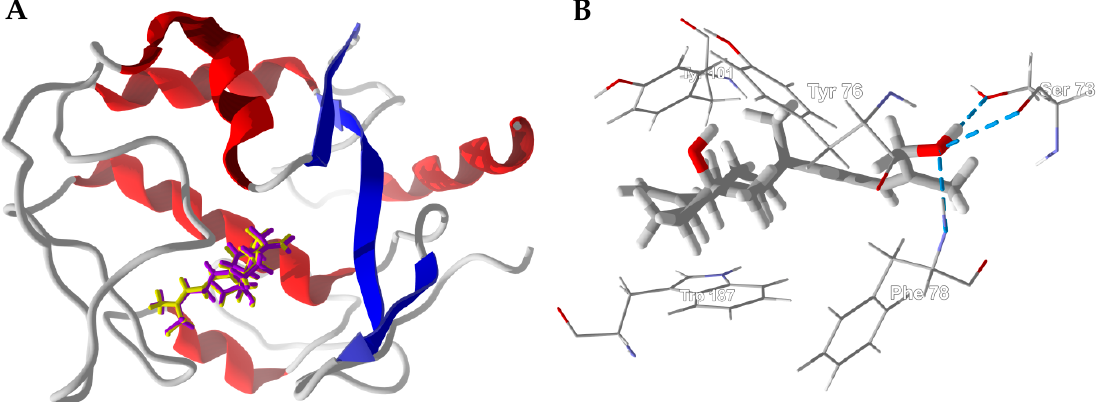
Figure 9. Human folate receptor β (HsFR β , PDB 4kn1). ( A ): Ribbon structure of protein showed the docked poses of boscartin A (yellow) and boscartin B (purple). ( B ): Lowest-energy docked pose of boscartin A in the binding site of HsFR β . Hydrogen-bonds are shown as blue dashed lines.